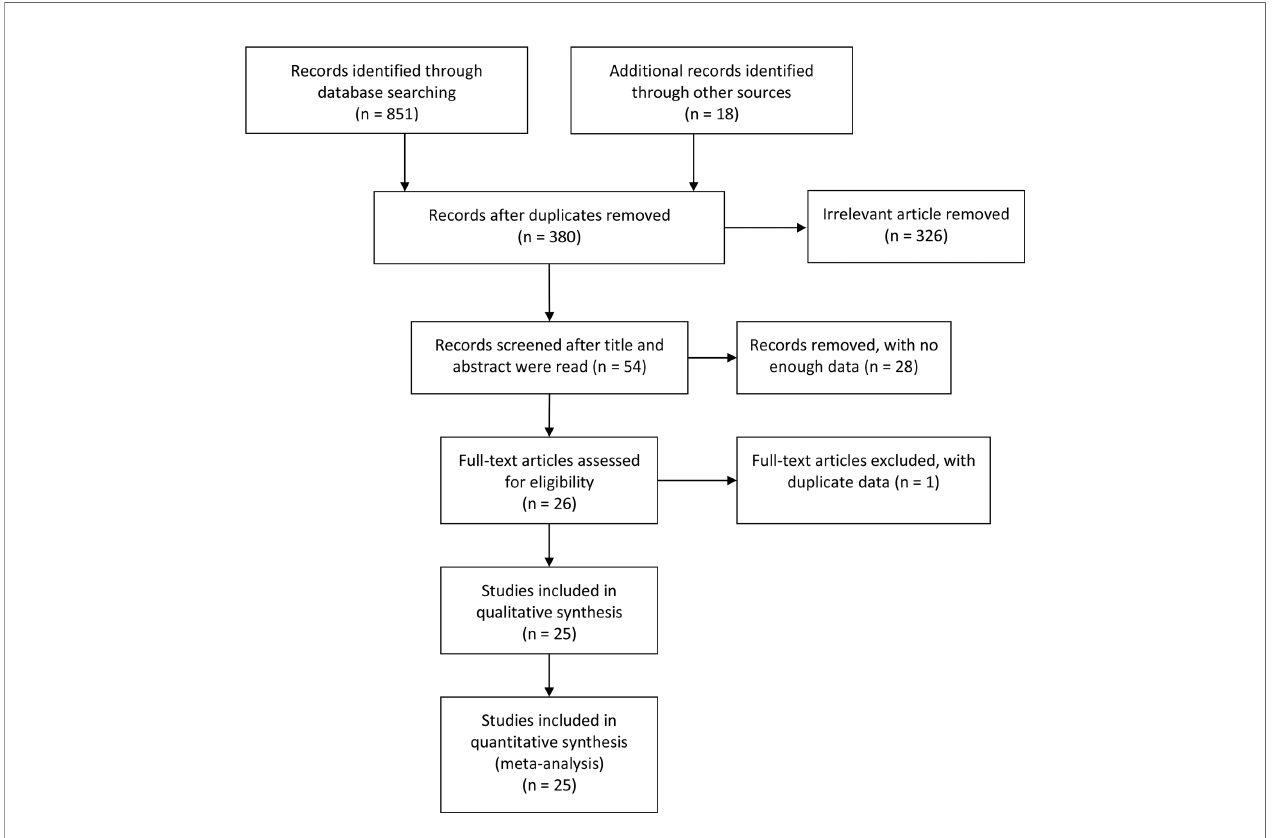
FIGURE 1 | Flow chart for literature search.